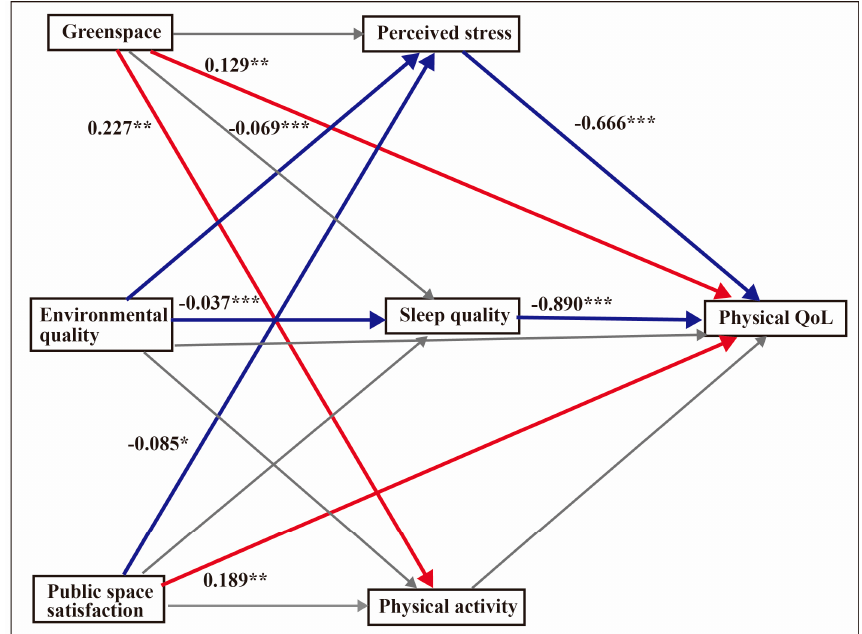
Figure 1. Mediation model for physical QoL. The analyses controlled for fruit intake and vegetable intake. Unstandardised coefficients are displayed. The values indicate the strength of the relationship between the variables. Red arrows depict positive relationships, blue arrows show negative relationships and grey arrows depict non-significance. * p < 0.05, ** p < 0.01, *** p < 0.001.